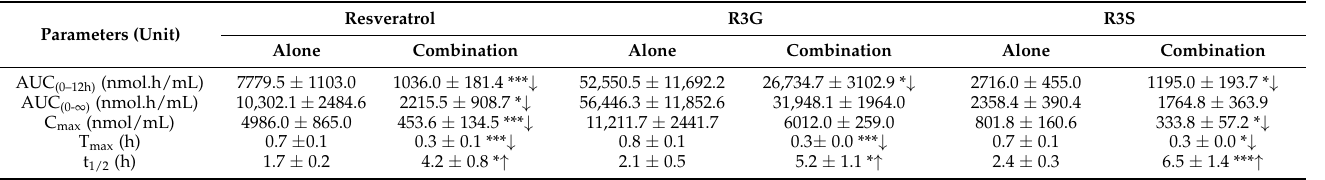
Table 4. Comparison of pharmacokinetic parameters of resveratrol and its main metabolites adminis- tered alone and combined with